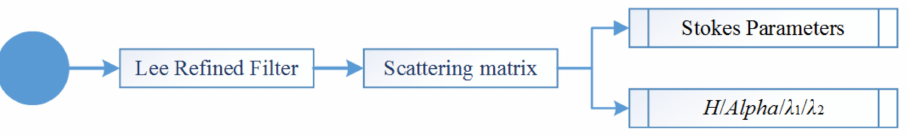
Figure 2. Polarization decomposition parameters: H / Alpha decomposition and Stokes